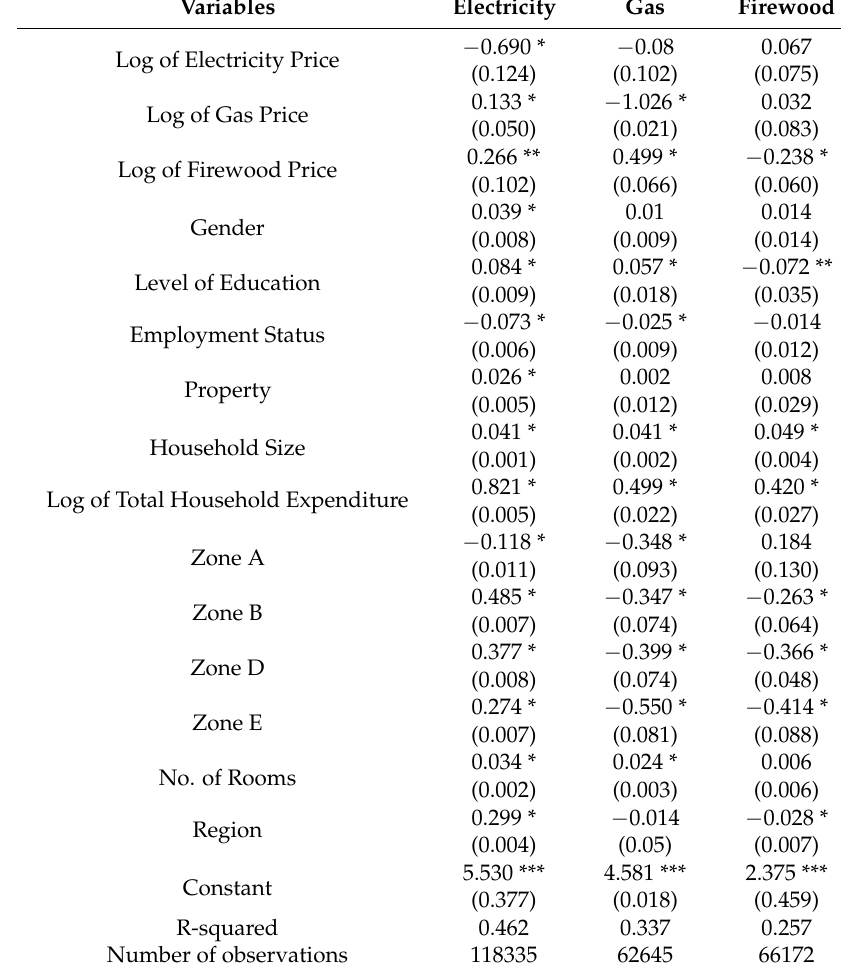
Table 6. Regressions Results (Dependent Variables are in Column